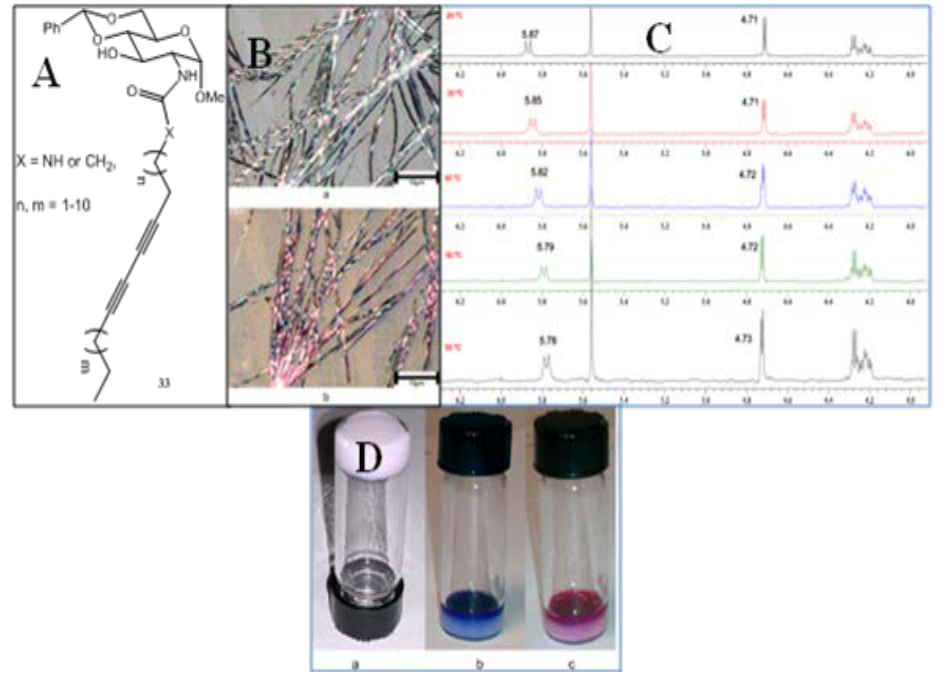
Figure 21. ( A ) Structure of the gelators; ( B , C ) optical micrographs of a gel formed by compound 33 (with n = 7, m = 8) in ethanol at 0.8 mg/mL. (a) Before treatment of the gel with UV light. (b) After irradiation with UV light for 1 min. ( C ): Temperature dependent 1 H-NMR study of the gelator from 20 to 55 °C. Note that the NH bond absorption shifted gradually from 5.87 to 5.78 ppm at 55 °C; ( D ) gel formed by compounds 33 (with n = 7, m = 8) and its responses to UV treatment. (a) An opaque gel formed by this compound in ethanol at 1.5 mg/mL. (b) The gel in vial ( A ) was treated with UV irradiation for 7 min through the top of the vial. (c) The gel in vial ( B ) turned purple-red when heating at 70 °C in a water bath. Reprinted with permission from [99]. Copyright 2015 American Chemical Society.